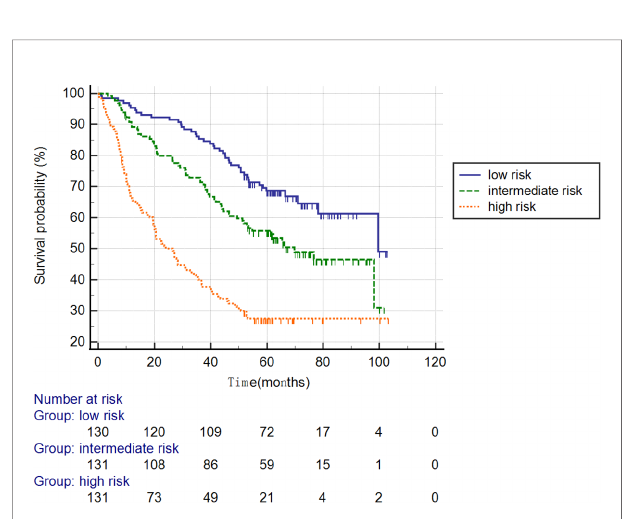
FIGURE 4 | The receiver operating characteristic (ROC) curve of the prognostic nomogram in the training dataset compared with other systems.